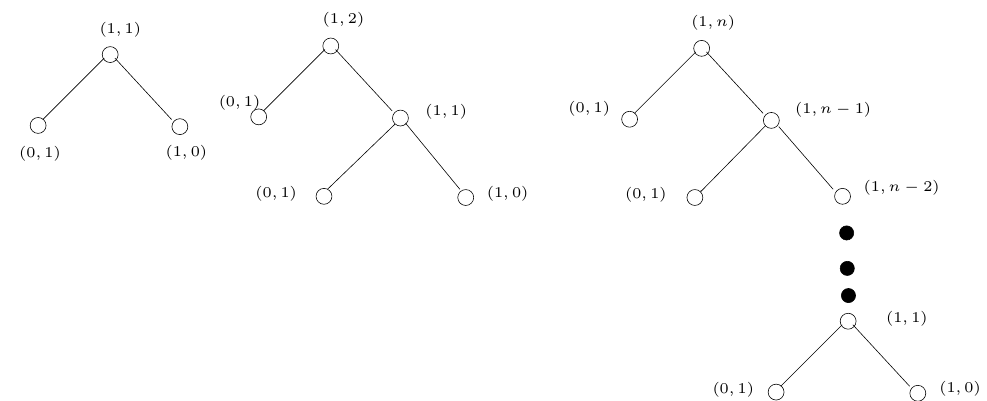
. If n (cid:21) 3 1 ;n ⌋g . for each k 2 f 2 ; : : : ; ⌊ n +1 k;n (cid:0) k +1 2